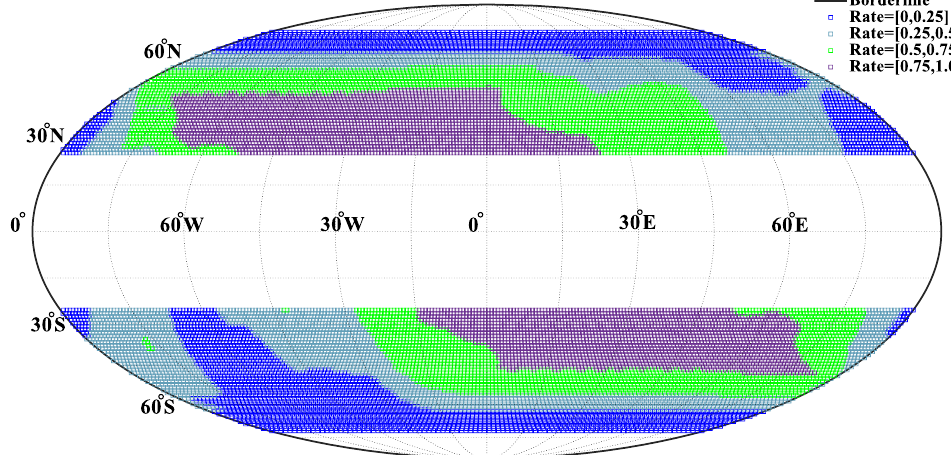
Figure 5. The result of difficult sky area statistics. Rate represents the statistical results for dif- ferent quantile intervals, with smaller values representing more difficult observations and larger weighting